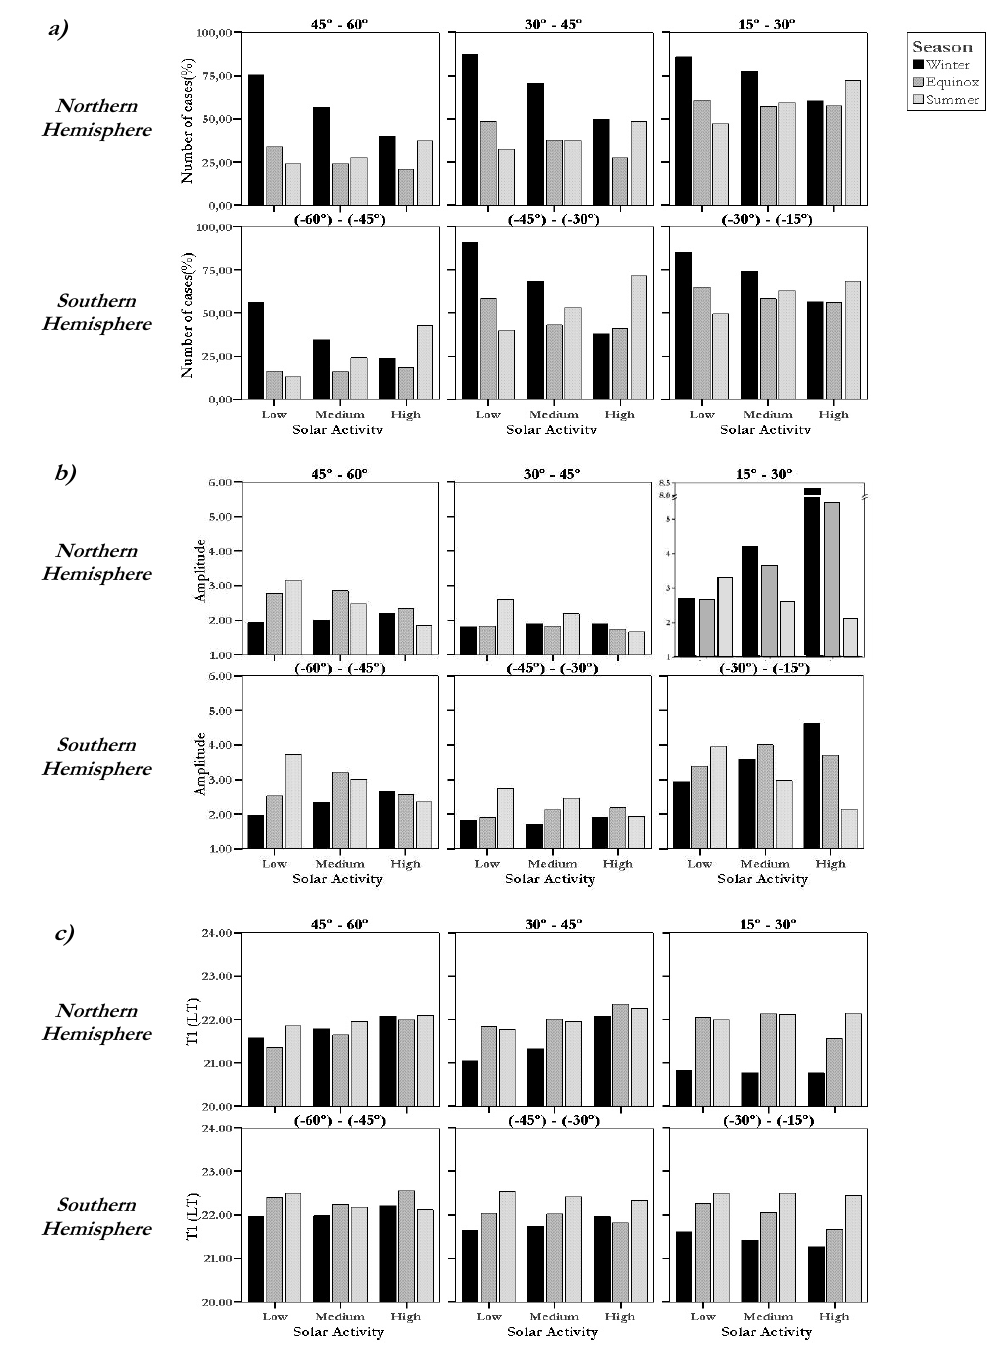
Fig. 2. Seasonal and solar variations of characteristic parameters of the first (pre-midnight) peak. Solar activity is classified in three levels: high solar activity (High), medium solar activity (Medium) and low solar activity (Low). Seasonal variability is arranged in three categories: winter, summer and equinox. See the text for details. (a) Probability of occurrence, (b) relative amplitude, (c) local time of occurrence; for 6 geomagnetic latitude ranges. Bars represent means. Negative latitudes represent Southern Hemisphere